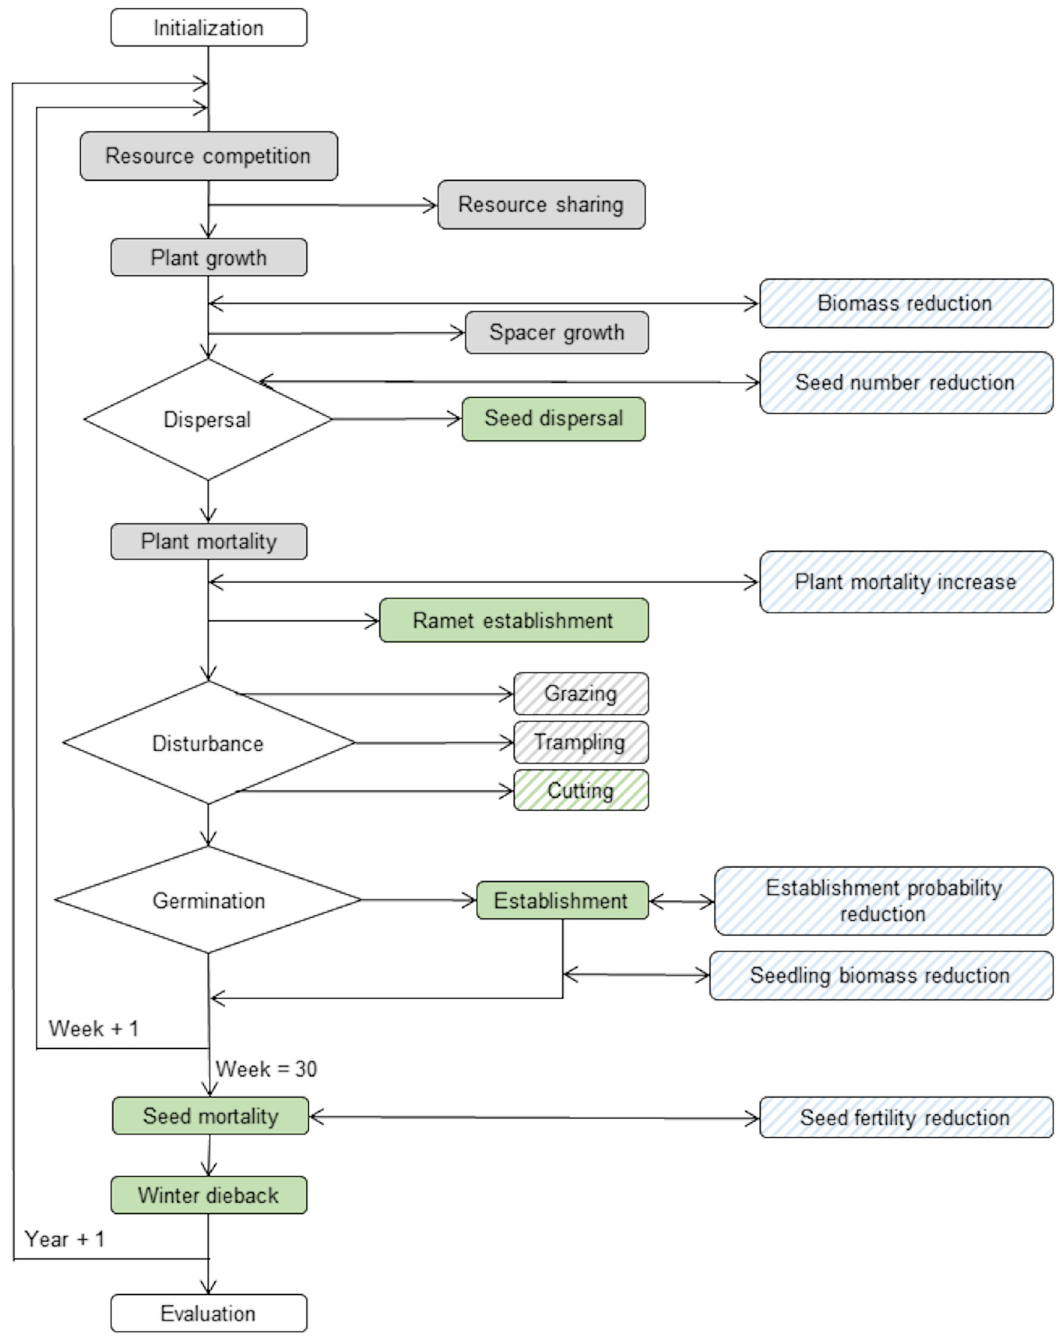
Fig 1. Flow chart of the processes simulated in IBC-grass. Grey boxes indicate processes occurring in each simulated week, green boxes indicate processes occurring only in specific weeks and blue boxes indicate potential herbicide-induced effects that the user can turn on or off. Striped boxes indicate processes the user can adjust and change.